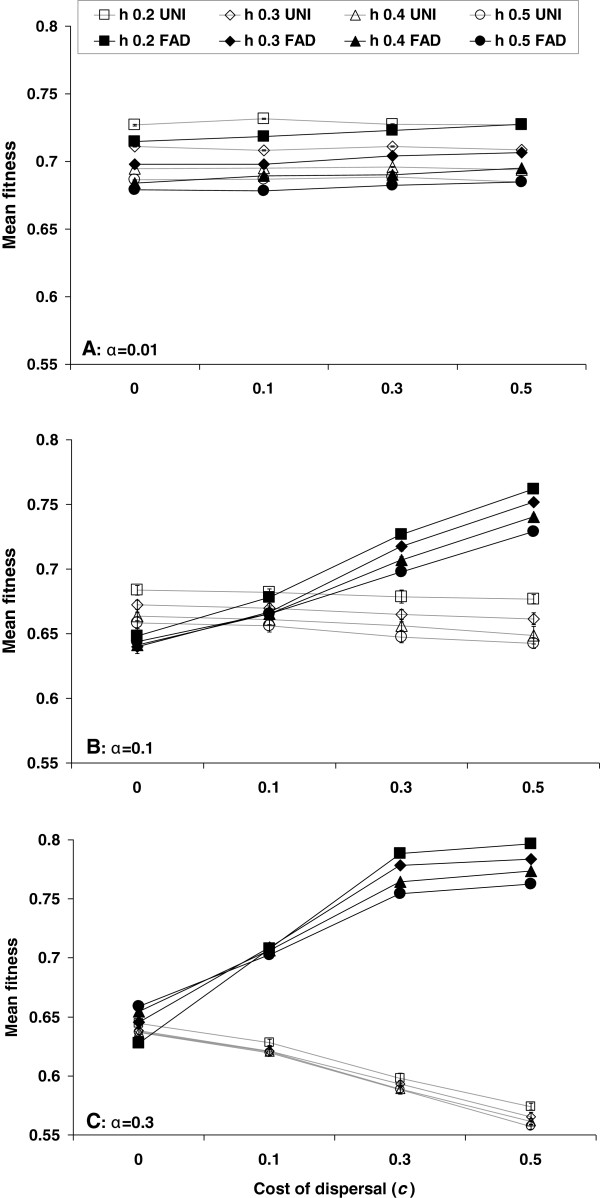
Mean fitness under different dispersal rules. Mean fitness (±SE) at the steady state in populations homogeneous at the modifier locus as a function of the cost of dispersal c, the dominance coefficient h, and the mean dispersal rate α (A: α = 0.01, B: α = 0.1, C: α = 0.3). The mean fitness of UNI (open markers) decreases with the cost, because the cost is a component of the fitness. This effect becomes stronger as the dispersal rate α increases (from A to C) and the cost is paid more often. In contrast, the mean fitness of FAD (filled markers) increases with the cost of dispersal, because less fit individuals pay the cost more often and deleterious alleles are purged from the population. As the dominance coefficient h increases, the masking of deleterious mutations in a heterozygous state weakens and fitness is slightly reduced in most cases. Note that in most cases the error bars, showing the standard error of the mean, are smaller than the markers.